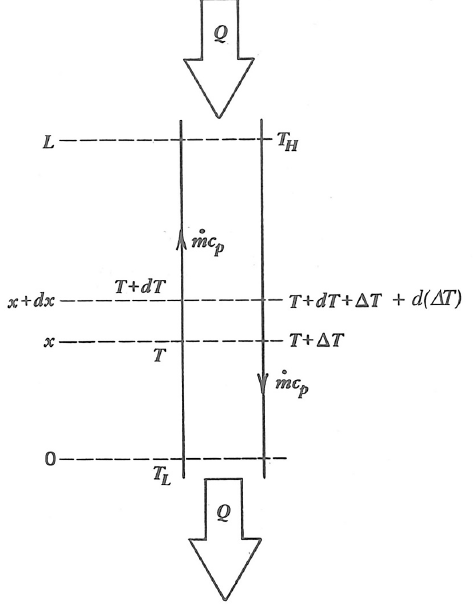
Figure 15. Counterflow heat exchangers leak energy by convection in the longitudinal direction (from top to bottom in the figure) [39,146].